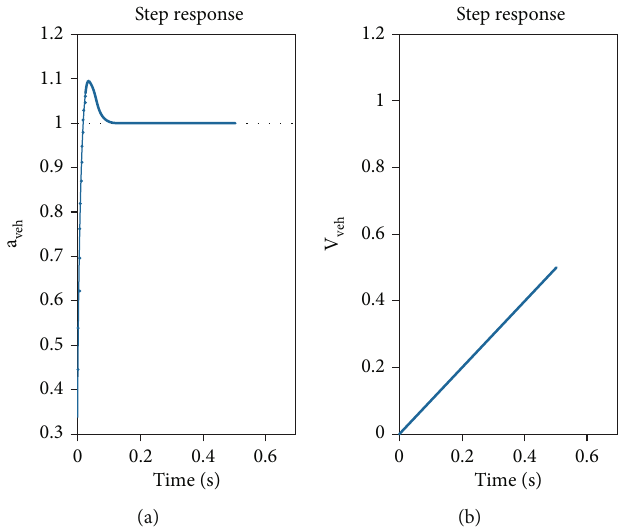
Figure 20: Vehicle acceleration (a) and speed (b) responses, respectively, in PID-CC (1).